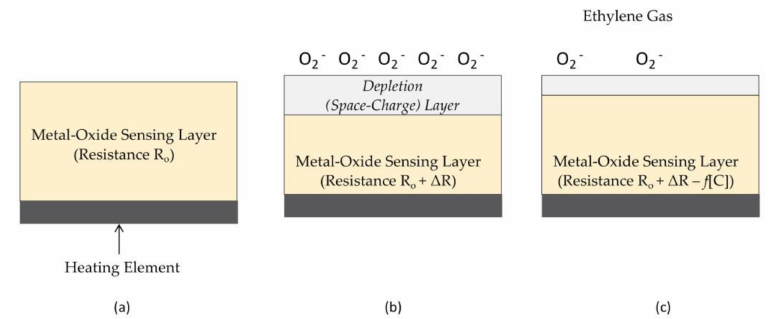
Figure 6. Metal-Oxide Gas Sensors. ( a ) In the absence of oxygen and reducing gases, the metal oxide has a baseline resistance on the order of kOhms. ( b ) Ambient oxygen on the surface of the sensing layer extracts oxygen from the underlying metal oxide, increasing resistance and creating a depletion (insulating) layer on the surface of the sensor. ( c ) A reducing gas such as ethylene binds with the oxygen on the surface, resulting in a re-injection of electrons into the sensing layer and a decrease in resistance that is a function of the ambient ethylene concentration. The heating element keeps the metal oxide sensing layer at an elevated temperature that maximizes the sensitivity of the sensor to desired